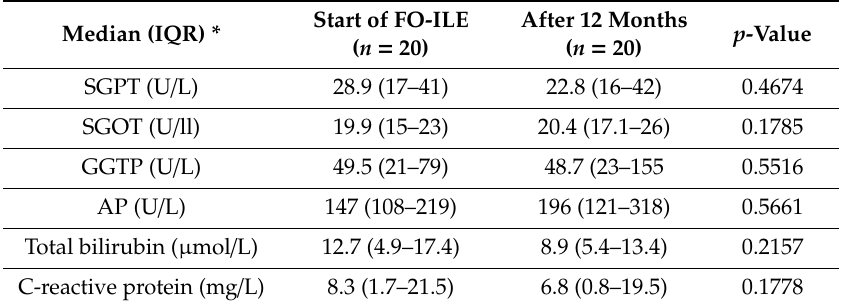
Table 1. Chronic intestinal failure (CIF) patients—liver tests.